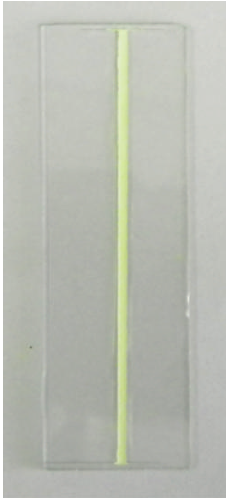
Figure 1: A photograph of the narrowband TLC plate after sep- aration of cholesterol and benzamide mixtures (the width of the narrowband is 3mm).